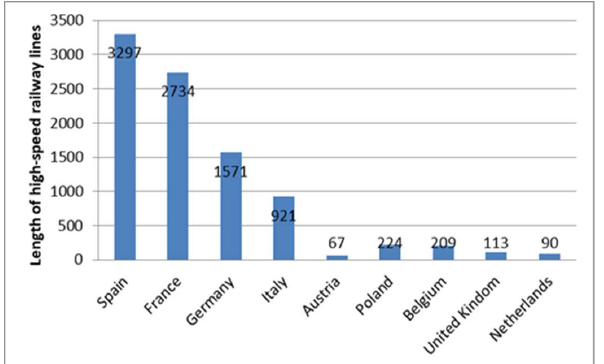
Figure 2 . The total length of high-speed railways in use in selected European countries in 2019 (in kilometers) [9] In Spain and France distances between cities are ideal for high-speed railways. In Spain, the largest city,